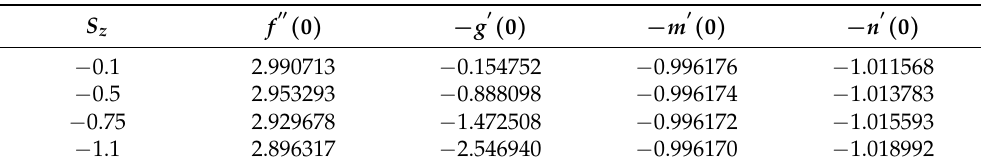
Table 5. Estimated values for f (cid:48)(cid:48) ( 0 ) , − g (cid:48) ( 0 ) , − m (cid:48) ( 0 ) , and − n (cid:48) ( 0 ) with fixed M x = 0.5, M y = 0.3, R m = 0.01, S = 1, and different values of S z .